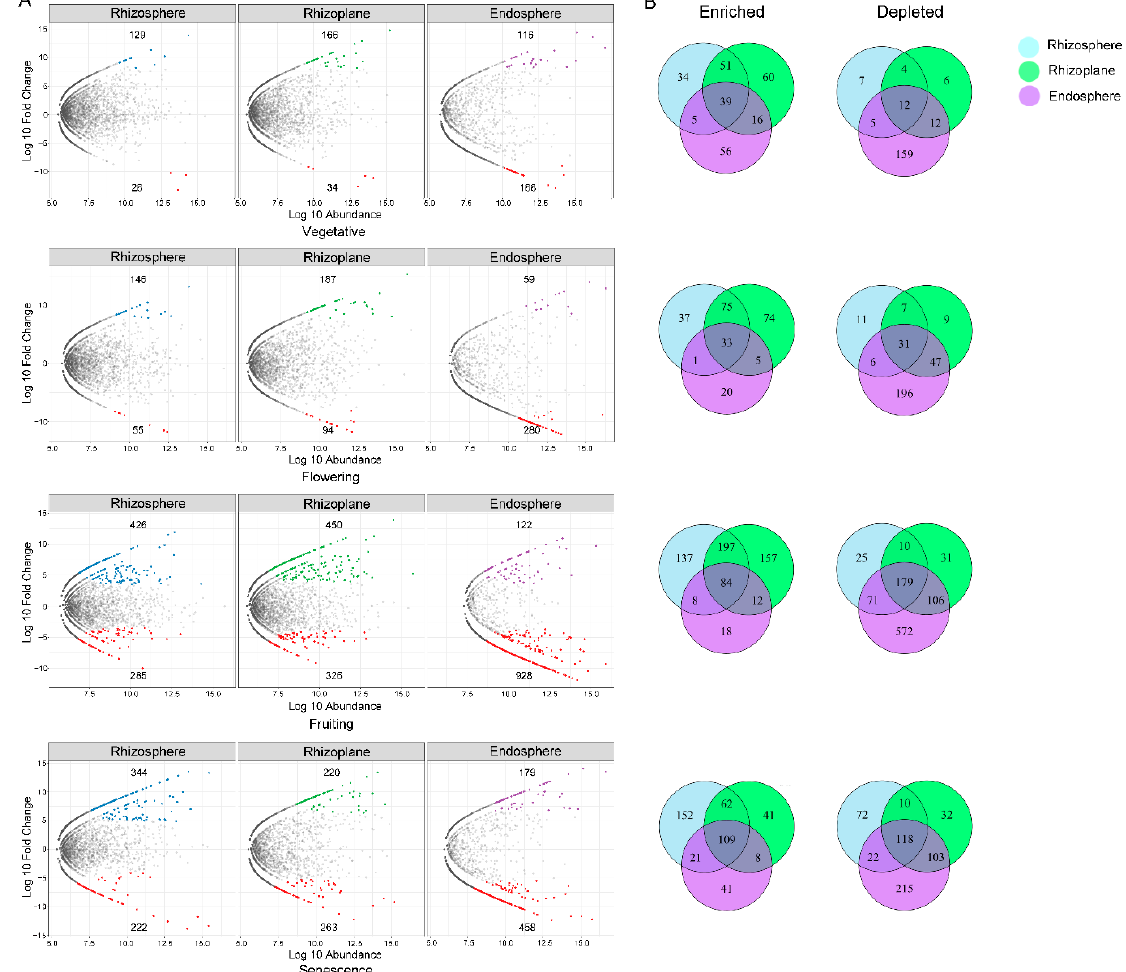
Figure 5. Comparison between the four compartments in each growth stage of bacterial communities. ( A ) Enrichment and depletion of 16S OTUs for each rhizocompartment (Rhizosphere, Rhizoplane, and Endosphere) compared to the bulk soil in the four growth stages as determined by differential abundance analysis. Each point represents an individual OTU, of which the blue, green, and purple points represent enriched OTUs in each compartment compared to the bulk soil, while the red ones indicate depleted OTUs, and the grey points represent no difference in abundance between each root compartment and bulk soil. The position along the y-axis represents the abundance fold change compared with the bulk soil. ( B ) Venn diagrams showing the numbers of differentially enriched and depleted OTUs between each compartment compared with bulk